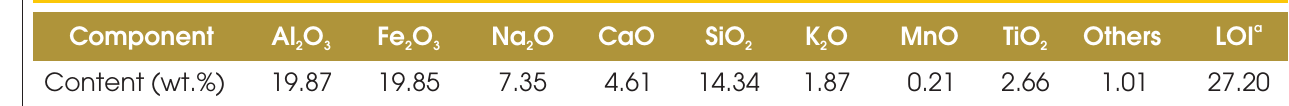
Table 2 – Chemical composition of red mud estimated by XRF